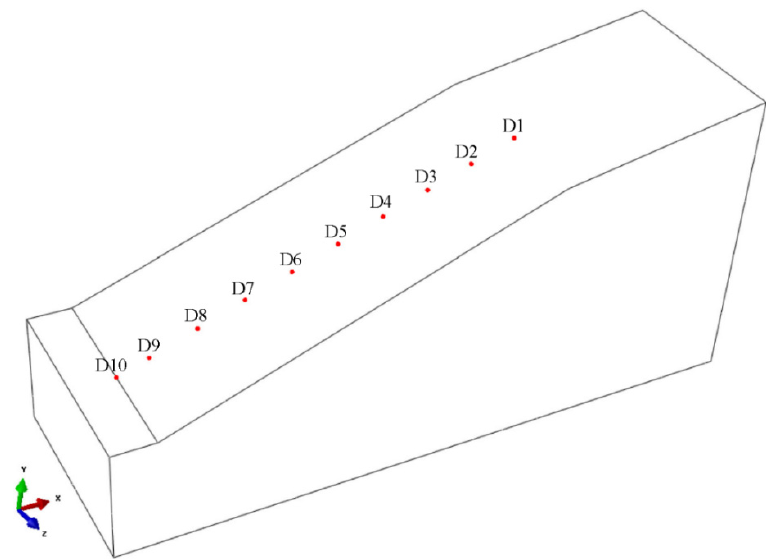
Figure 4. Monitoring-point layout.